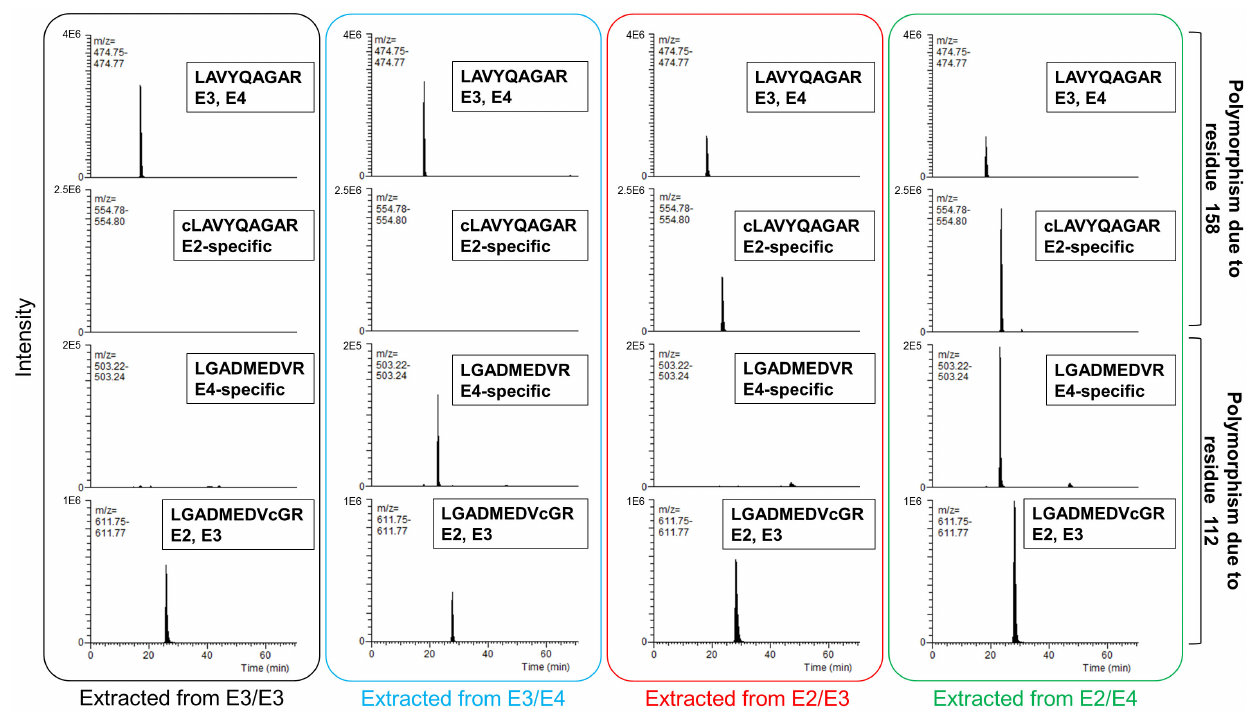
Figure 2. Serotyping in heterozygous combinations. Figure shows representative ion chromatograms of the wild-type (E3/E3) and all heterozygous combinations (E2/E3, E3/E4, E2/E4). Tryptic peptide polymorphisms correspond to each ApoE isoform. As described under ‘‘ApoE serotyping’’ in the Materials and Methods , the correlation between ApoE genotypes and isoforms enables determination of the genotype from the blood ApoE isoform